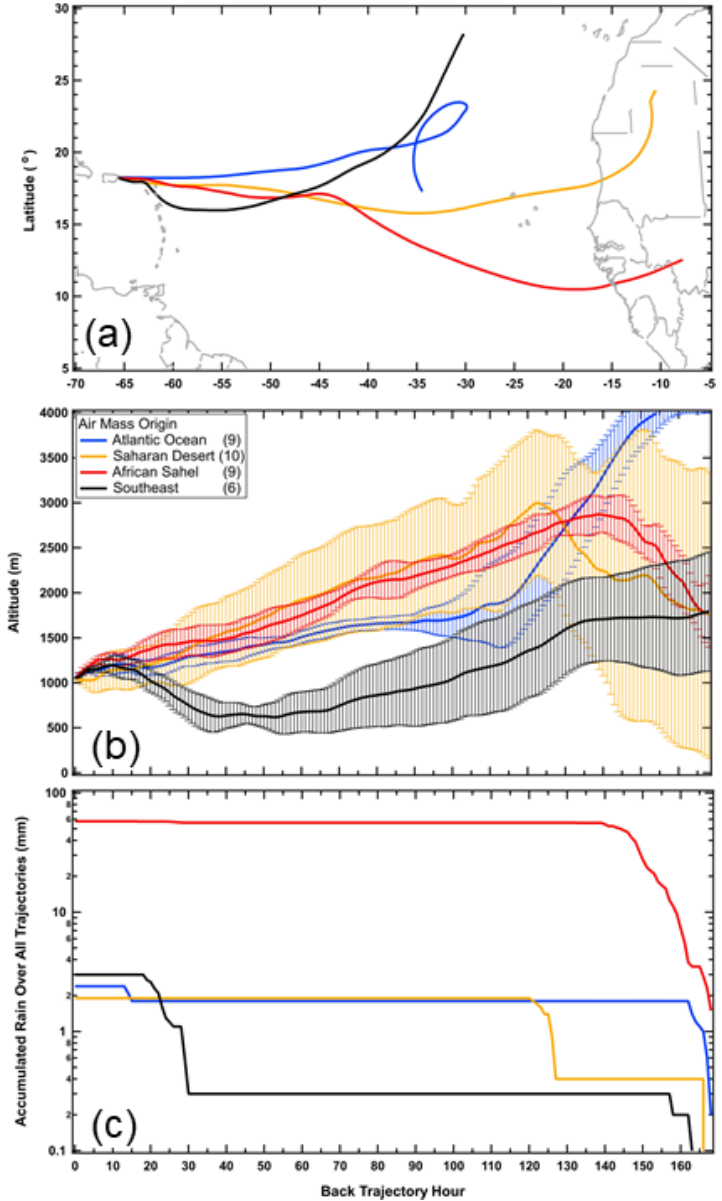
Figure 4. HYSPLIT back-trajectory analysis. (a) The 7d averaged back trajectories are shown for air masses with different origins: AO (blue curve), SD (yellow), AS (red), and approaching PDE from the southeast (black). The numbers in parentheses indicate the number of se- quential trajectories averaged for each type. (b) The average altitudes during the 7d travel before reaching PDE are shown as a function of back-trajectory hour for the four air mass types. The vertical bars are 1 standard deviation about the mean value. (c) The accumulated rain (mm) that has fallen out of the air mass, as simulated by the HYSPLIT model, is shown as a function of hour before reaching PDE.